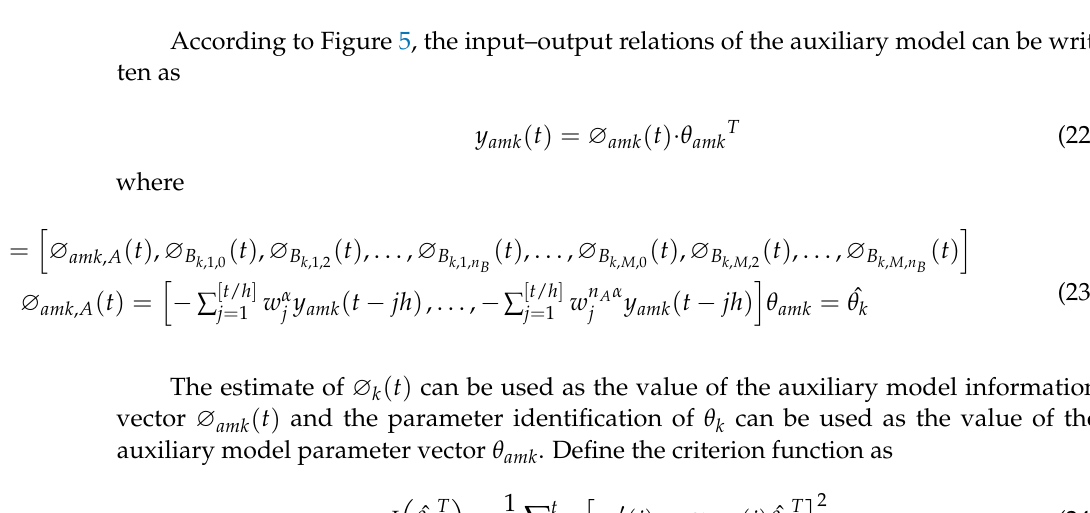
Figure 5. The MIMO Hammerstein model based on the auxiliary model.